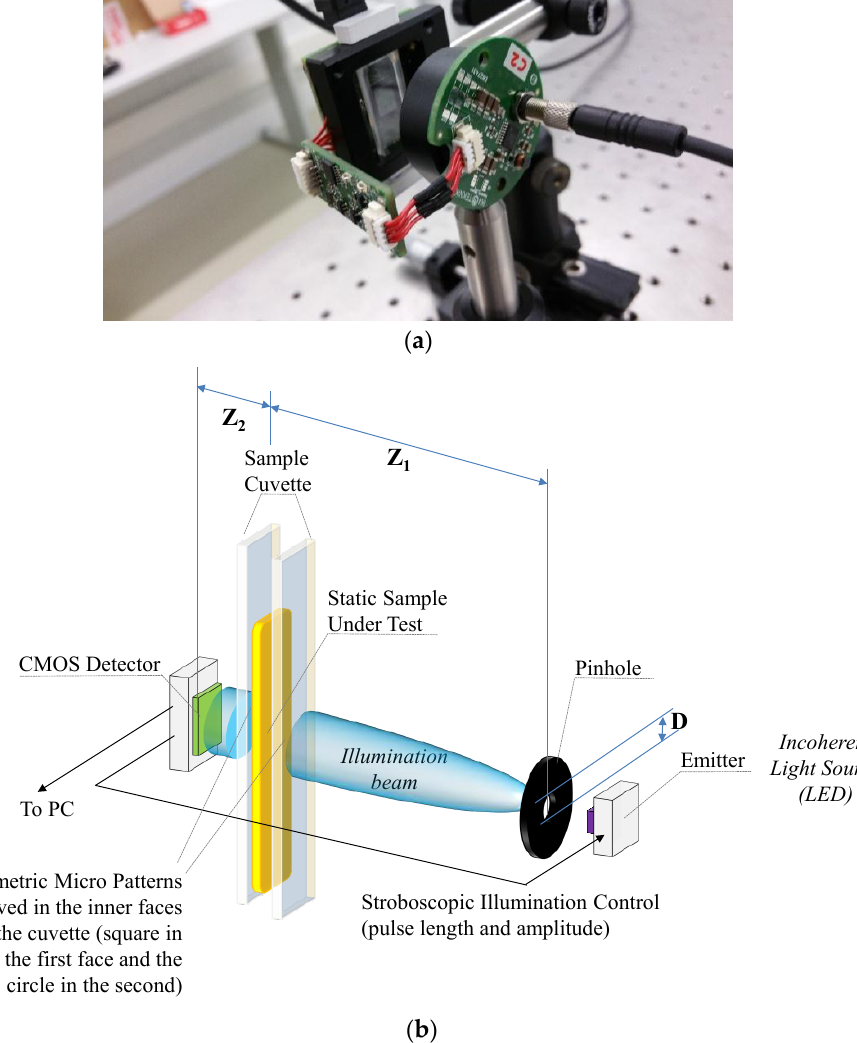
Figure 6. ( a ) Photo and ( b ) block diagram of the optical test bench.